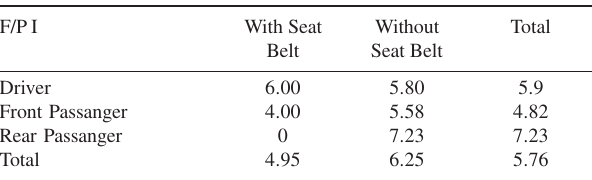
Table 3 - F/P I (number of fracture lines per patient) applied to different groups.